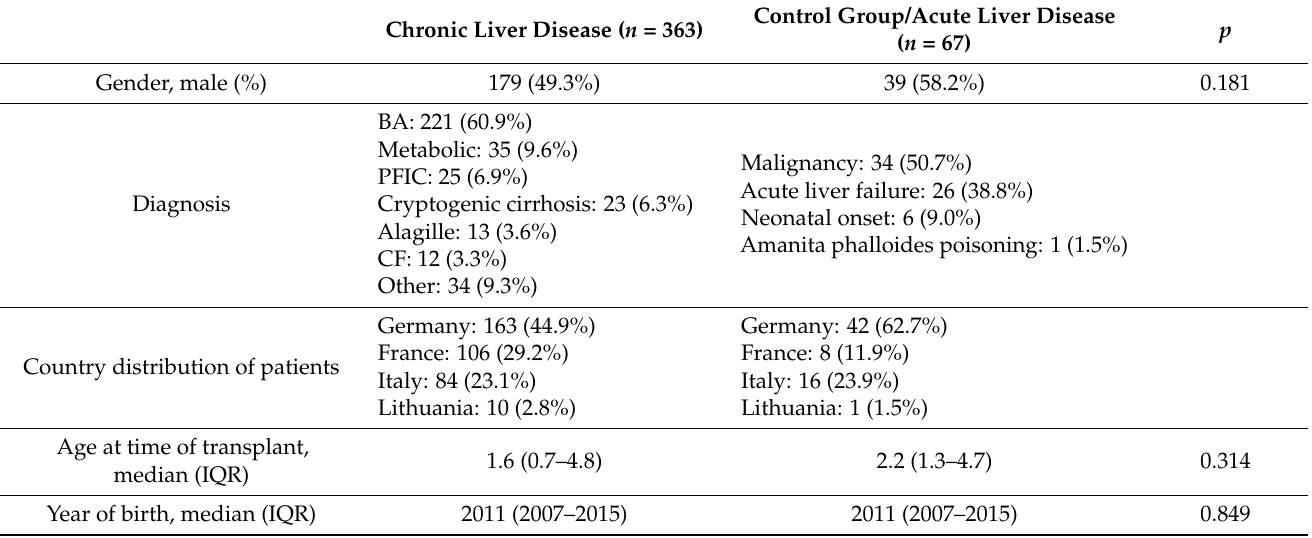
Table 1. Patient data of 430 children who underwent liver transplantation between January 2003 and April 2021 from five centers in